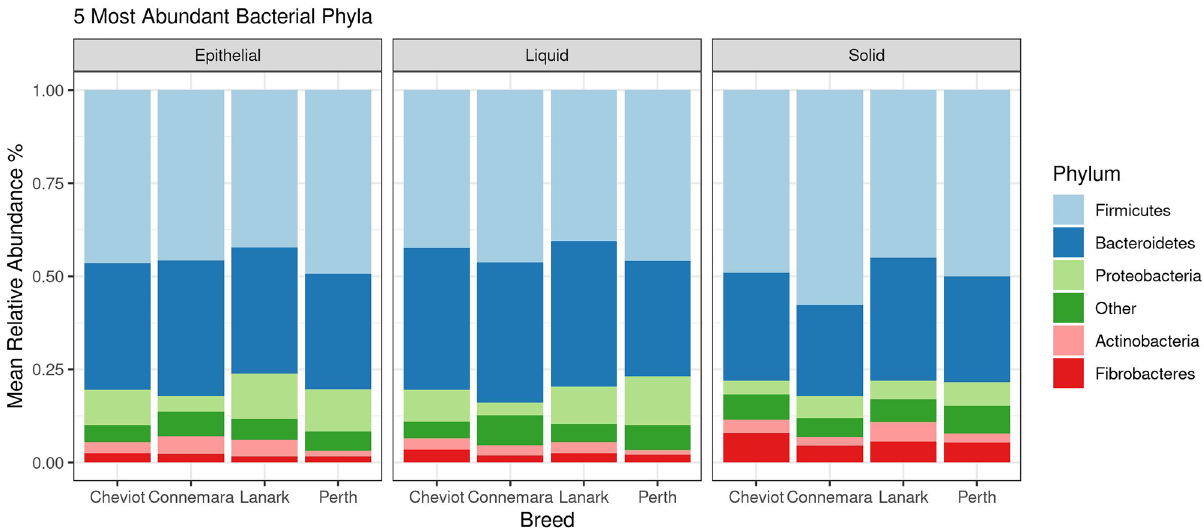
Figure 1. Stack barchart representing the mean relative abundance of the 5 most dominant phyla across breeds (i.e. Cheviot, Connemara, Lanark, Perth) for solid liquid and epithelial ruminal fractions. Solid (Cheviot n = 8,